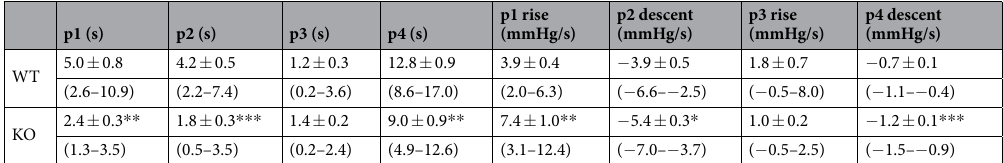
KO Table 2. Comparisons between WT and P2Y 6 -KO mice with respect to parameters associated with bladder contraction. The symbols of p1, p2, p3, and p4 indicate 1st, 2nd, 3rd, and 4th phases, respectively, of BCD. The p1 rise, p2 descent, p3 rise, and p4 descent are calculated as: (pressure change from PT to MVP)/p1, (pressure change from MVP to TP)/p2, (pressure change from TP to CPP)/p3, and (pressure change from CPP to RP), respectively. Numbers in parentheses are ranges. Significant difference from variable of WT mice: * P <